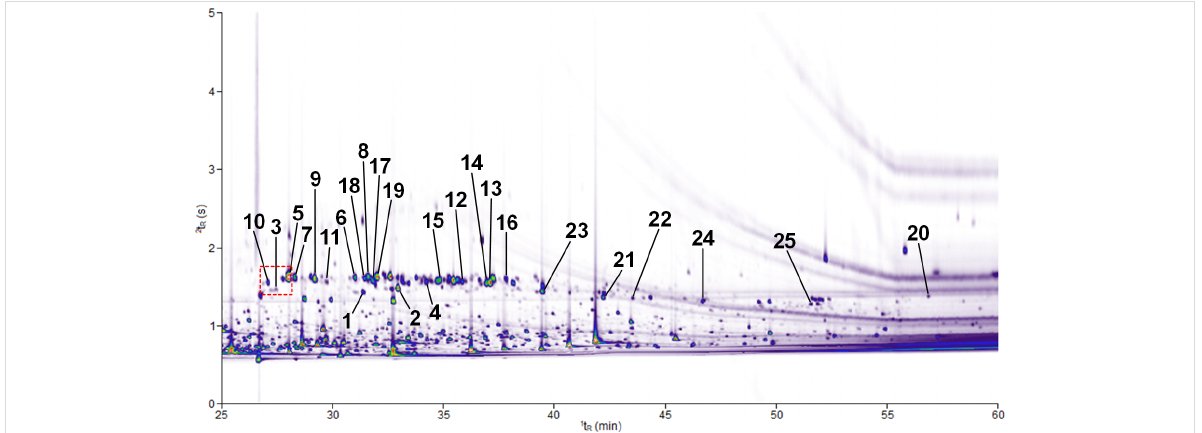
Figure 1: Contour plot of a HS-SPME–GC×GC–TOF–MS chromatogram (TIC) demonstrating the separation of volatile compounds isolated from the headspace of grape berries of the red wine variety Lemberger ( Vitis vinifera subsp. vinifera , clone 1Gm, exocarp). 1 t R (X-axis) corresponds to the retention time on the primary column and 2 t R (Y-axis) to the retention time on the secondary column. The color gradient reflects the intensity of the TOF–MS signal on a white background from low (violet) to high (red). Numbers at peaks refer to compound numbers as defined in Figure 2 and Table 1. The area framed in red including the volatile compounds numbered 10, 3 and 5 is enlarged in Figure 3.